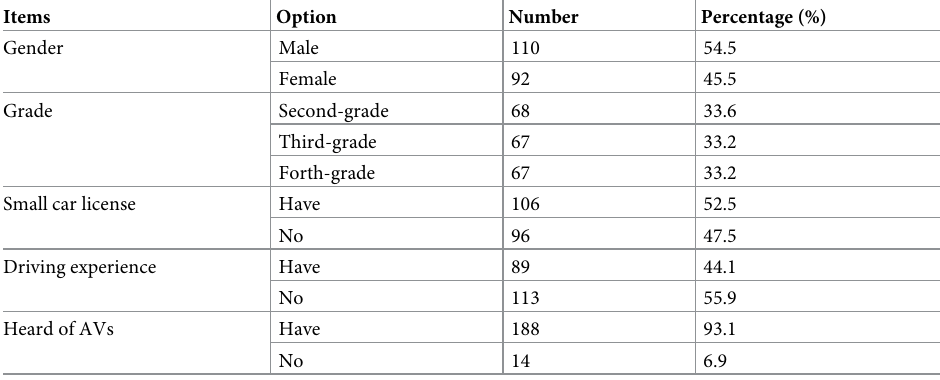
Table 1. Statistical description ( N =